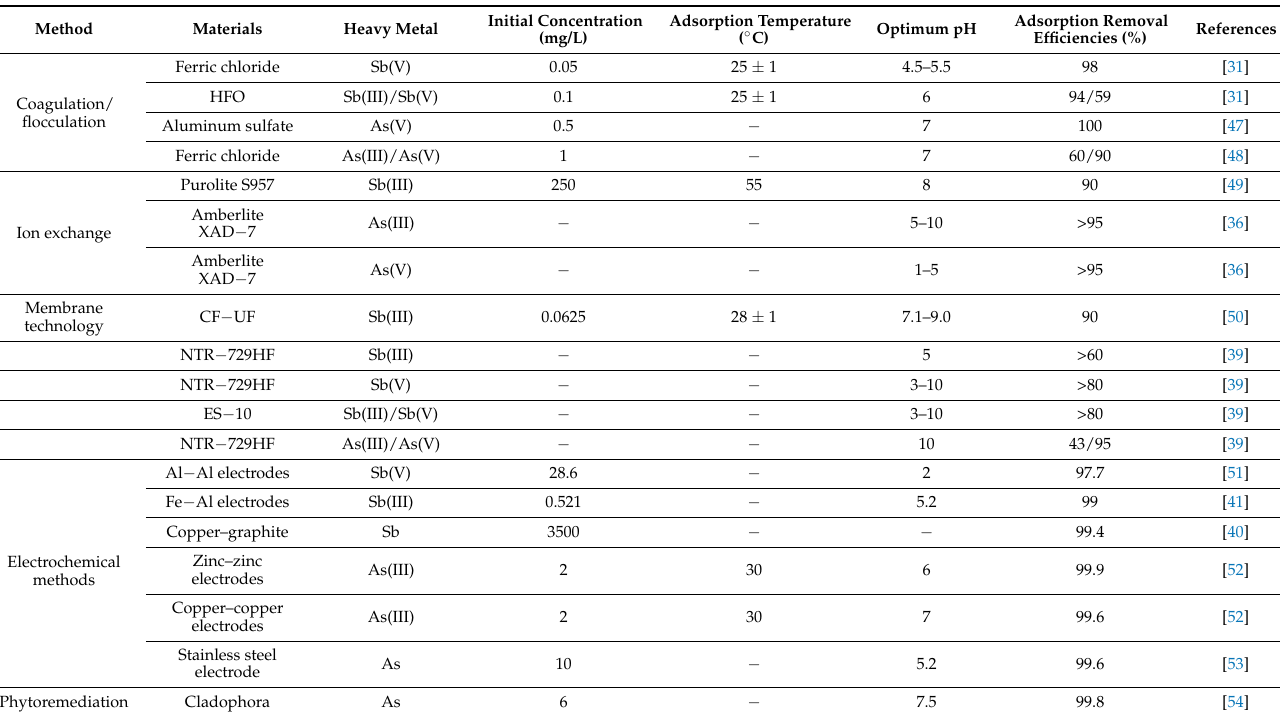
Table 1. Adsorption capacity and other parameters of different pollution treatment technologies for removing antimony and